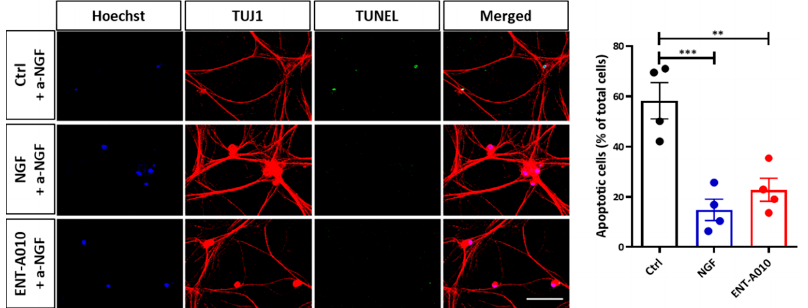
Figure 4. ENT-A010 promoted DRG neuron survival. DRG neurons were cultured for 2 days in a NGF-free and anti-NGF supplemented medium in the presence of NGF, ENT-A010 or control vehicle. Left panel: Cells stained for TUJ1 (red), with TUNEL (green) or Hoechst (blue). Scale bar: 100 µ m (applies to all photos). Right panel: The quantification demonstrates the number of TUNEL + (apoptotic) cells as % of Hoechst + (total) cells. Data are shown as mean ± SEM, n = 4, **: p < 0.01, ***: p < 0.001.